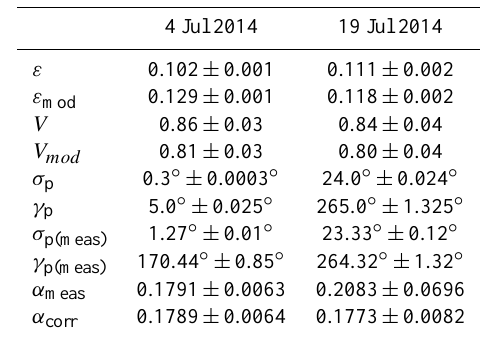
Table 2. Measured and retrieved sensor inclinations and direc- tions and daily average albedo, including all standard deviations, at WHW on 4 and 19 July 2014 on a horizontal concrete surface.